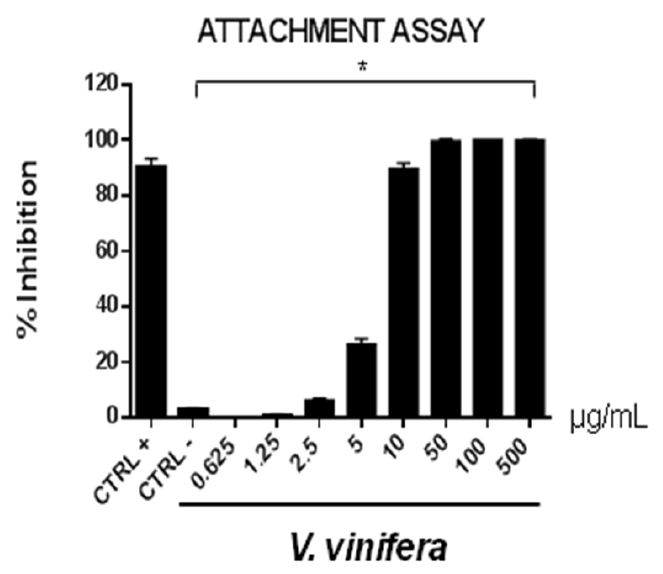
Figure 5. Early viral attachment assay of leaf extract ( µ g/mL) against HSV-1. The antiviral activity is expressed as % of inhibition. The results presented were obtained from three independent experiments. Data are mean ± SD. Statistical differences were analyzed via Student’s t -test, a value of p ≤ 0.05 was considered significant, with * p ≤ 0.05.